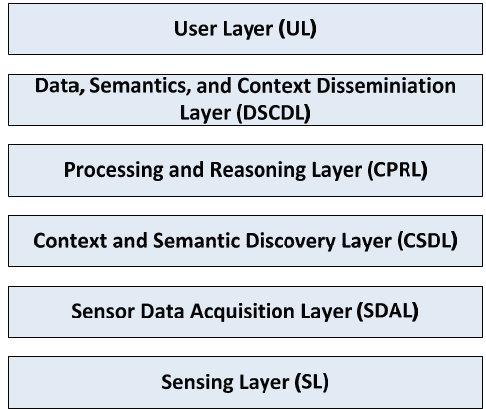
Figure 2. CA4IOT architecture, as described in